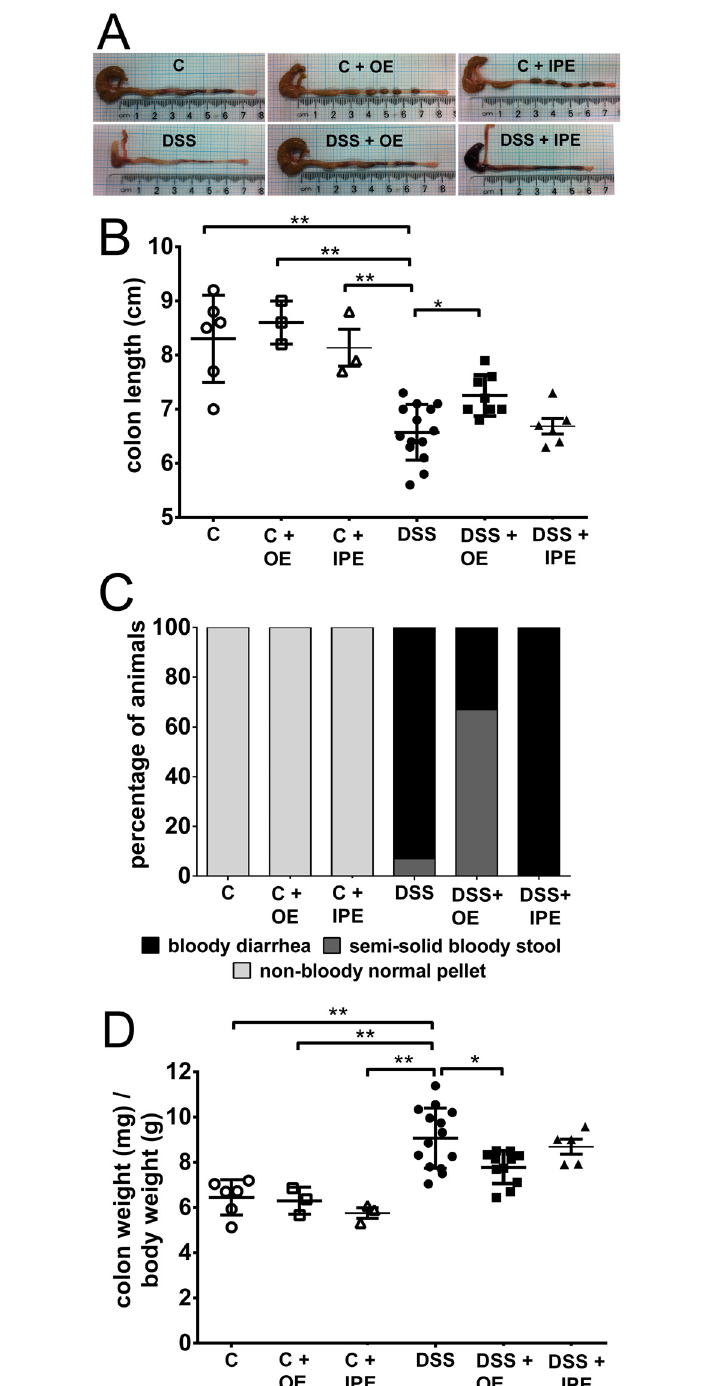
Fig 2. Effect of enoxaparin on macroscopic appearance of colon. (A) Representative images of colons from mice treated with and without enoxaparin. (B) The colons were measured for their length. (C) The appearance of colon luminal content was evaluated before the measurement of colon weight. (D) The relative colon weight was presented as colon weight divided by body weight. Results are expressed as mean ± SD of n = 3 – 14 mice. * p < 0.05 and ** p < 0.01. Control, C; control with oral enoxaparin, C+OE; control with intraperitoneal injection of enoxaparin, C+IPE; untreated colitis, DSS; colitis with oral enoxaparin, DSS+OE; colitis with intraperitoneal injection of enoxaparin, DSS+IPE.